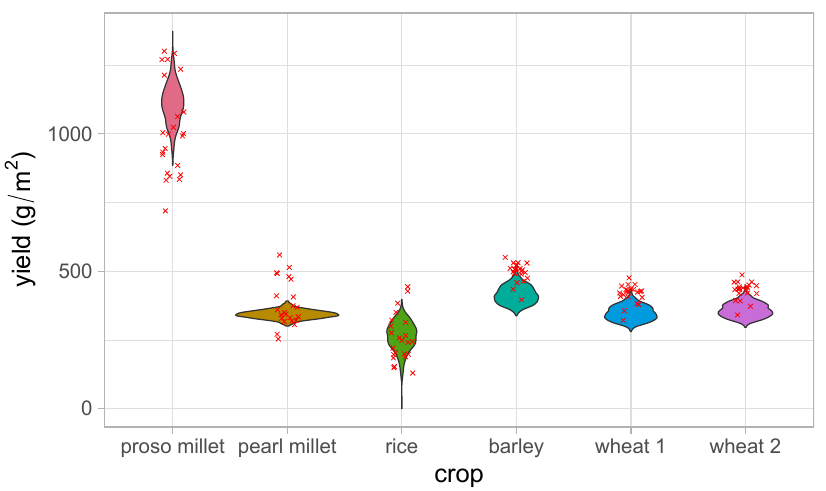
Figure 4. Harvested yield per crop in experiment